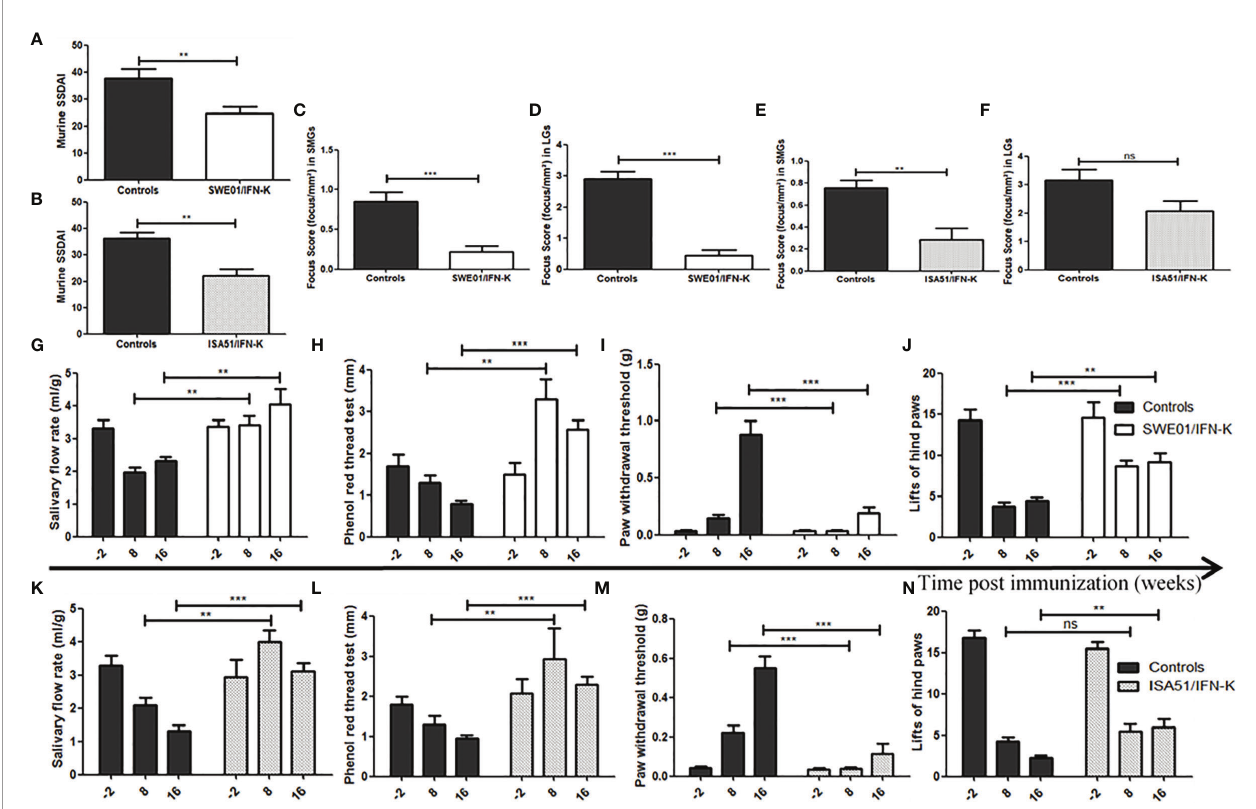
FIGURE 3 | Improving Sjögren ’ s syndrome in MRL/lpr mice. Sjögren ’ s syndrome-like features were monitored and compared between IFN-K-treated mice and their controls (not treated, PBS and KLH groups). (A, B) Modeled on the EULAR Sjögren ’ s Syndrome Disease Activity Index (ESSDAI), we designed a Murine Sjögren ’ s Syndrome Disease Activity Index (MuSSDAI), using all the applicable features in MRL/lpr mice. MuSSDAI was assessed at the end of follow-up (n=20 in SWE01 cohort and n=25 in ISA51 cohort), as was determined (C – F) the focus score, i.e. the degree of lymphoid in fi ltration (one focus = an aggregate of ≥ 50 mononuclear cells), in (C, E) submandibular and (D, F) lacrimal glands. (G, K) Salivary fl ow rates, (H, L) tear production, (I, M) mechanical and (J, N) thermal sensitivities were assessed 2 weeks before immunization (n=26 in both cohorts), 8 weeks (n=26 in both cohorts) and 16 weeks (n=21 in SWE01 cohort and n=25 in ISA51 cohort) post-immunization. Error bars indicate mean ± S.E.M. Ns **p < 0.01 and ***p < 0.001. SMG, submandibular glands; LG, lacrimal